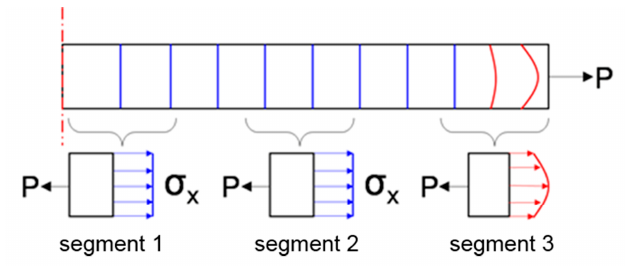
Figure 3. Saint-Venant’s principle showing the stress distribution of a slim member under tension P.